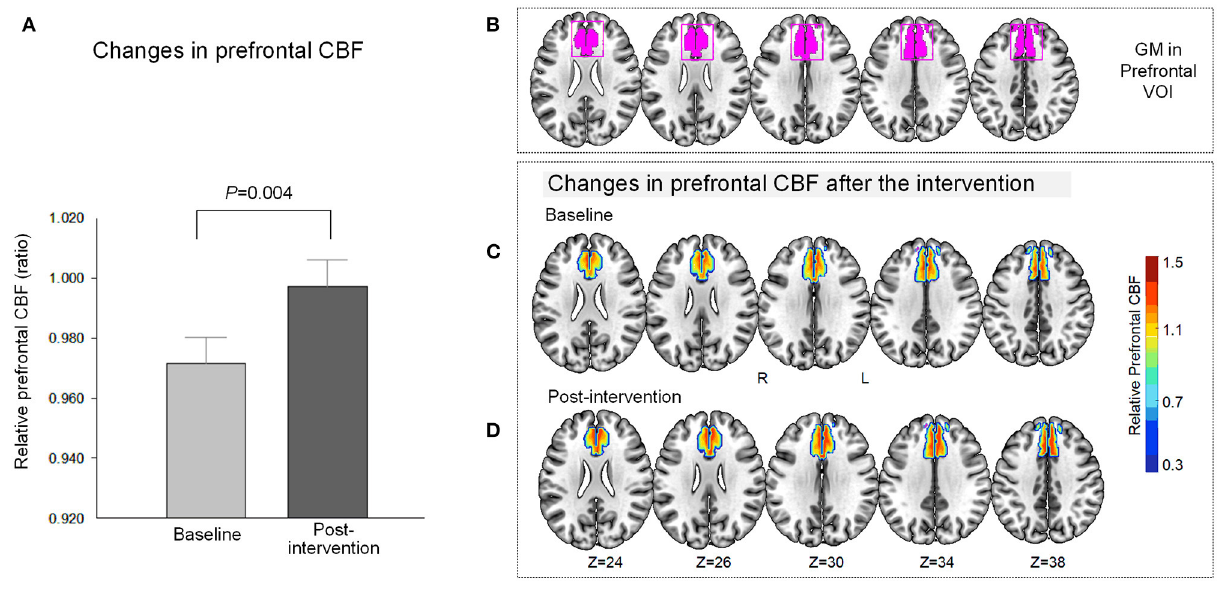
FIGURE 2 | Changes in relative prefrontal CBF after the relaxation training. (A) The relative CBF within the medial prefrontal region increased ( t = − 3.32, P = 0.004) in relation to the 10 daily sessions of the computerized relaxation training program. (B) Anatomical localization of the prefrontal VOI and the gray matter within the VOI of the study are presented as violet-colored box and violet-colored binary map on the brain template, respectively. The relative CBF map within the prefrontal VOI was overlaid on the brain template for at baseline (C) and after the intervention (D) . The red color indicates higher relative CBF, while the blue color indicates lower relative CBF as indicated in the vertical color bar. CBF, cerebral blood flow; GM, gray matter; VOI,